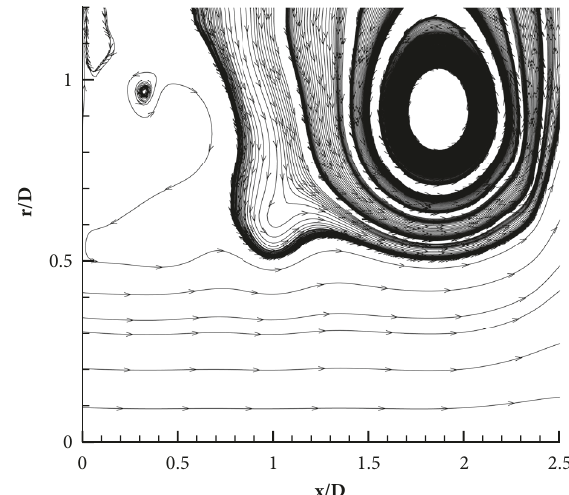
Figure 9: Counterpartof the snapshot considered in Figure 5 but as numerically computed for